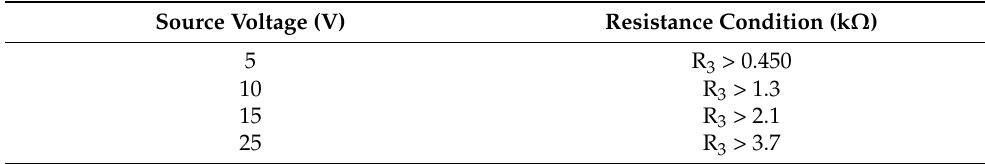
Table 5. Conditions for keeping the self-heating temperature change less than 1 ◦ C in a Wheatstone bridge